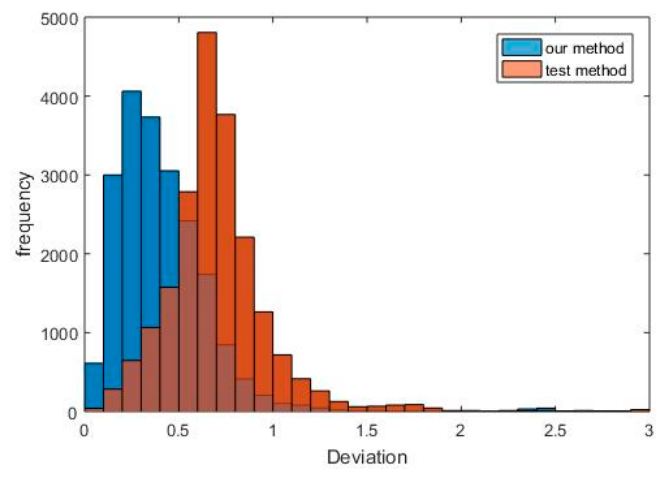
Figure 20. The inspection results in Figure 2h.